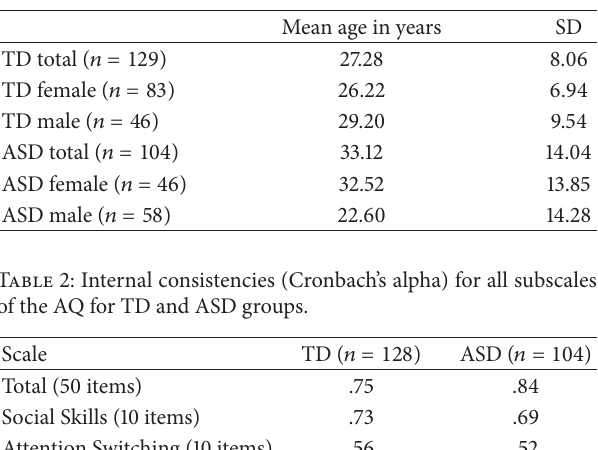
Table 1: Mean age for ASD and TD participants.